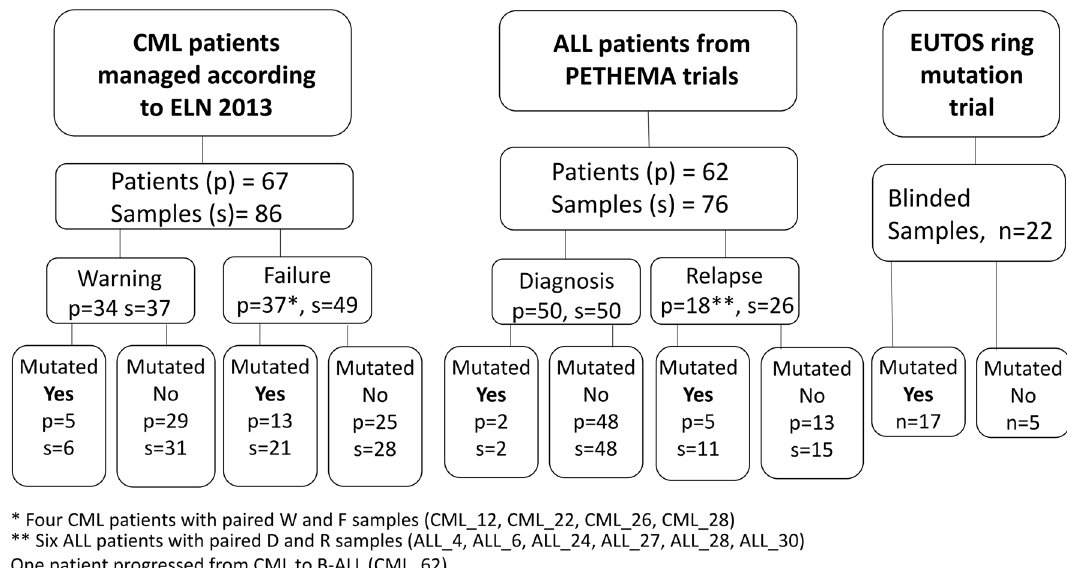
Figure 1. Study flow chart. Overview of the design and distribution of the patients and samples analyzed by RNA-NestedNGS. ALL acute lymphoblastic leukemia, CML chronic myeloid leukemia, D diagnosis, ELN European leukemia net, F failure, R relapse, W warning.